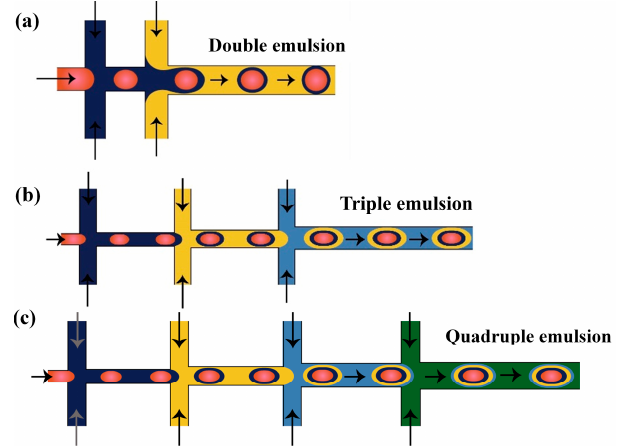
Figure 23. PDMS device with serial flow focusing drop makers with alternating wettability for the production of high-order emulsions: ( a ) The production of double emulsion using two drop makers; ( b ) The production of triple emulsion using three drop makers; ( c ) The production of quadruple emulsion using four drop makers [15].